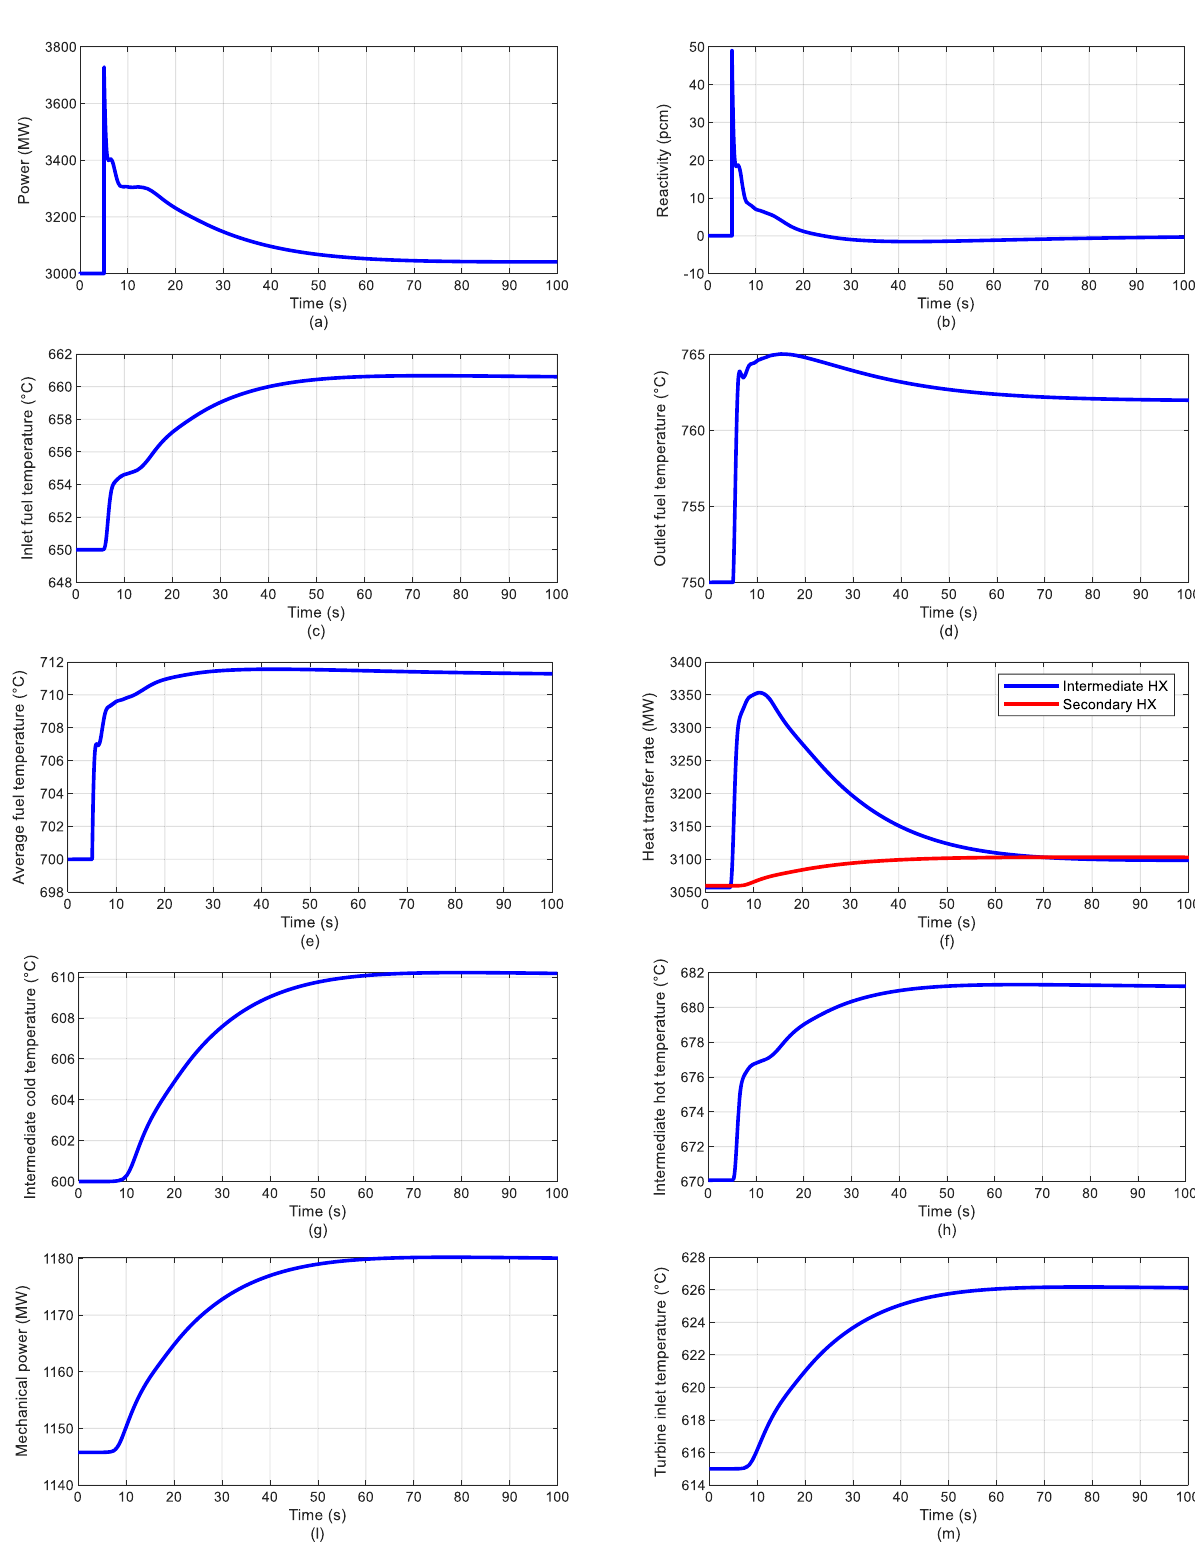
Fig. 16. Controlled variables evolution for 0.1 $ external reactivity step insertion: (a) reactor thermal power; (b) net reactivity variation; (c) fuel inlet temperature; (d) fuel outlet temperature; (e) fuel average temperature; (f) heat transfer rates in the heat exchangers; (g) intermediate salt minimum temperature; (h) intermediate salt maximum temperature; (i) turbine mechanical power; (m) helium turbine inlet